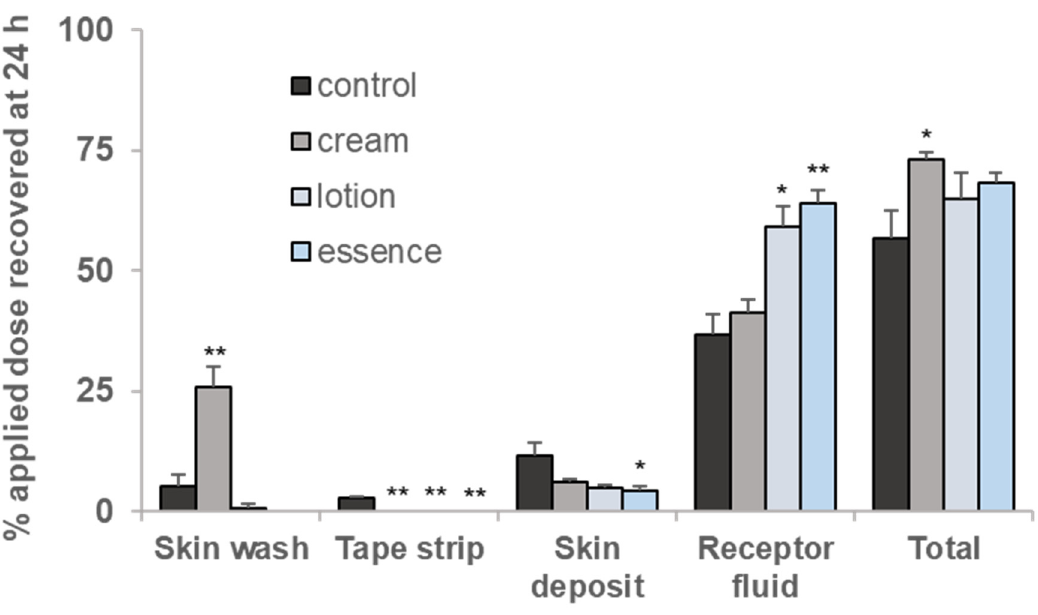
Figure 5. Distribution of BIT applied as a finite dose (10 μ g/cm 2 ) for 24 h after pre-treating cosmetics in minipig skin. Skin wash: the dose remaining on the skin surface and donor compartment, Tape